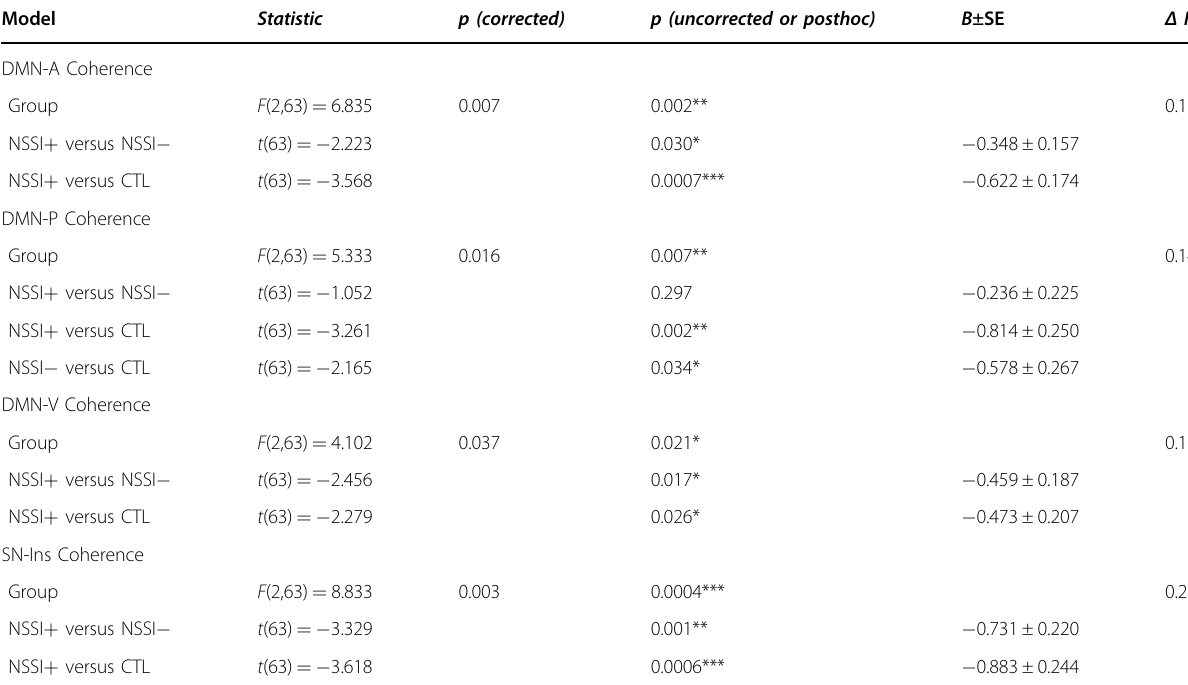
Table 3 Results of statistical models with a signi fi cant overall effect of group (NSSI + , NSSI − , CTL) on network coherence with planned linear contrast tests (NSSI + versus NSSI − and NSSI + versus